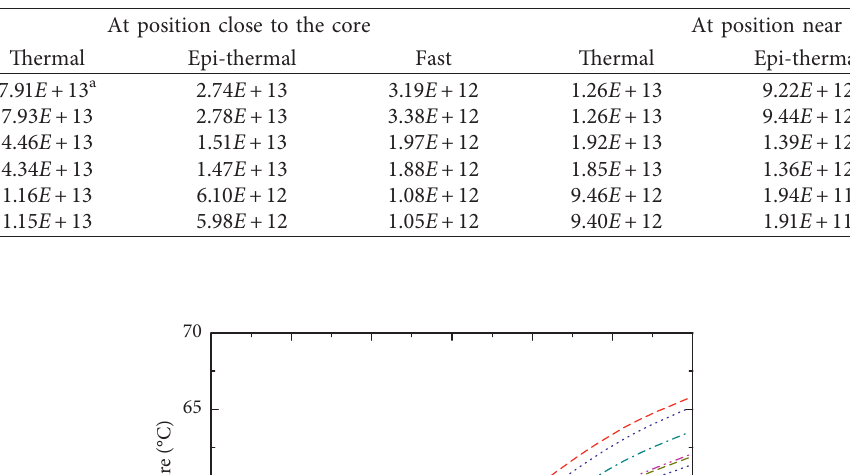
Table 5: Neutron fluxes (n · cm − 2 · s − 1 ) at the horizontal beam tubes.